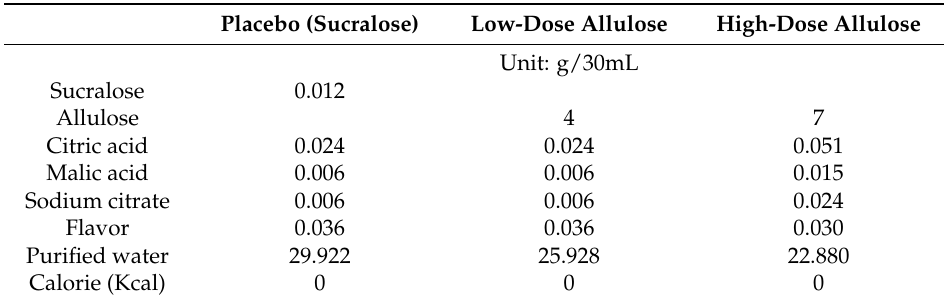
Table 1. Composition of test drinks used in the preliminary trial for dose-dependent effect of D -allulose in overweight or moderately obese human